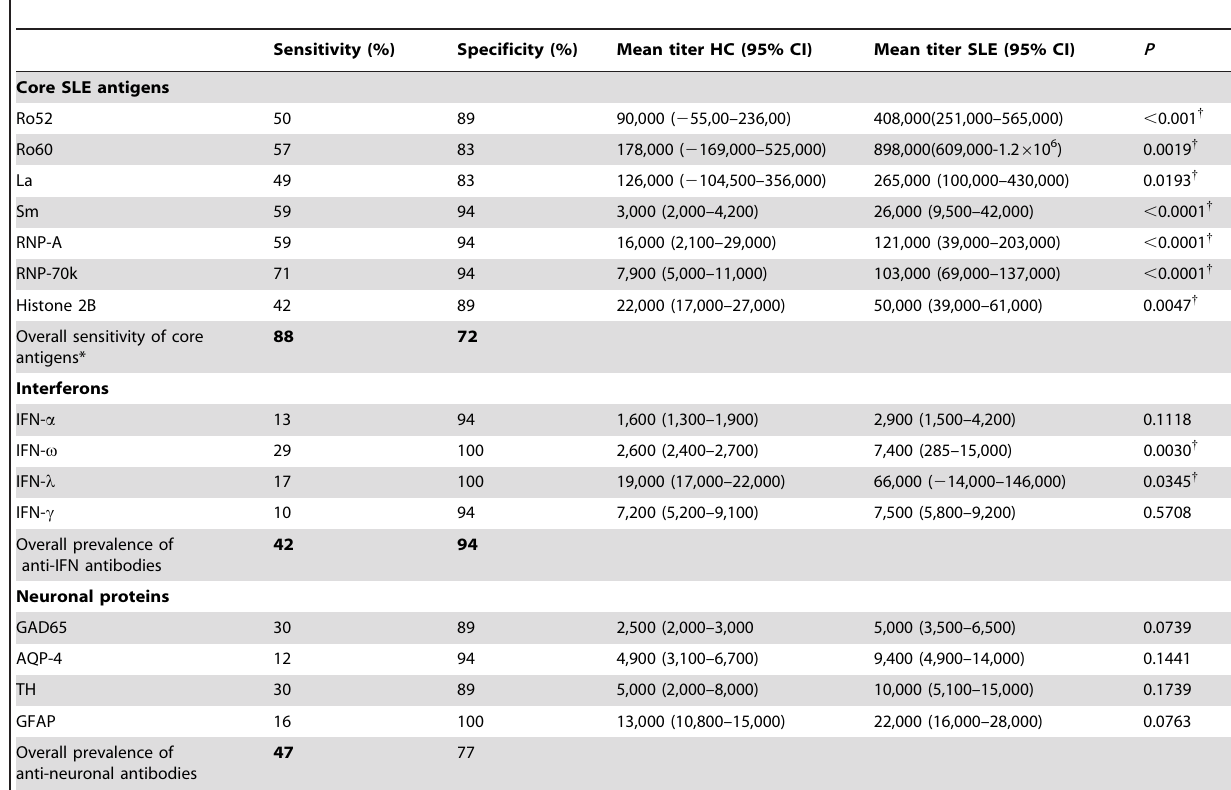
Table 1. LIPS diagnostic autoantibody characteristics in